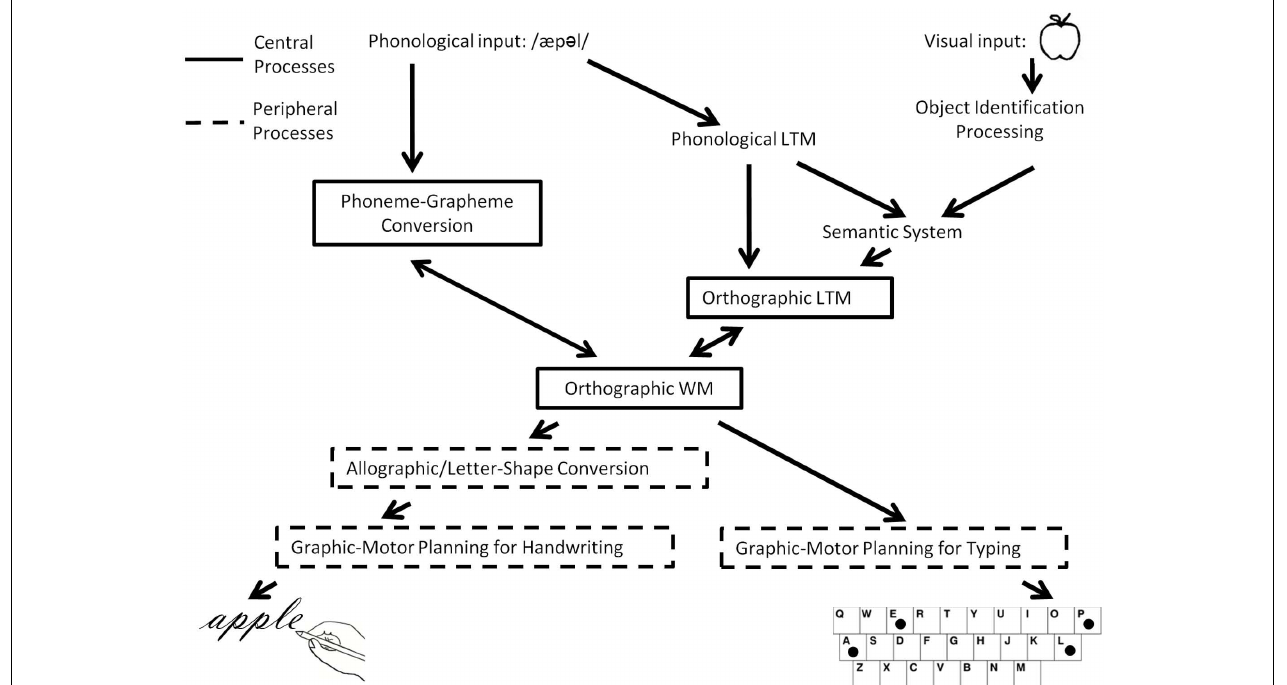
FIGURE 1 |A schematic depiction of the cognitive architecture of the written word production system.